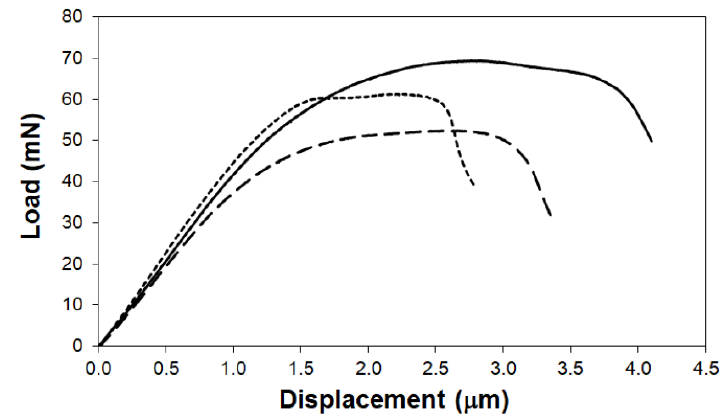
Figure 10. Load–displacement curves for T91 steel obtained during micro-punch tests on FIB membranes.